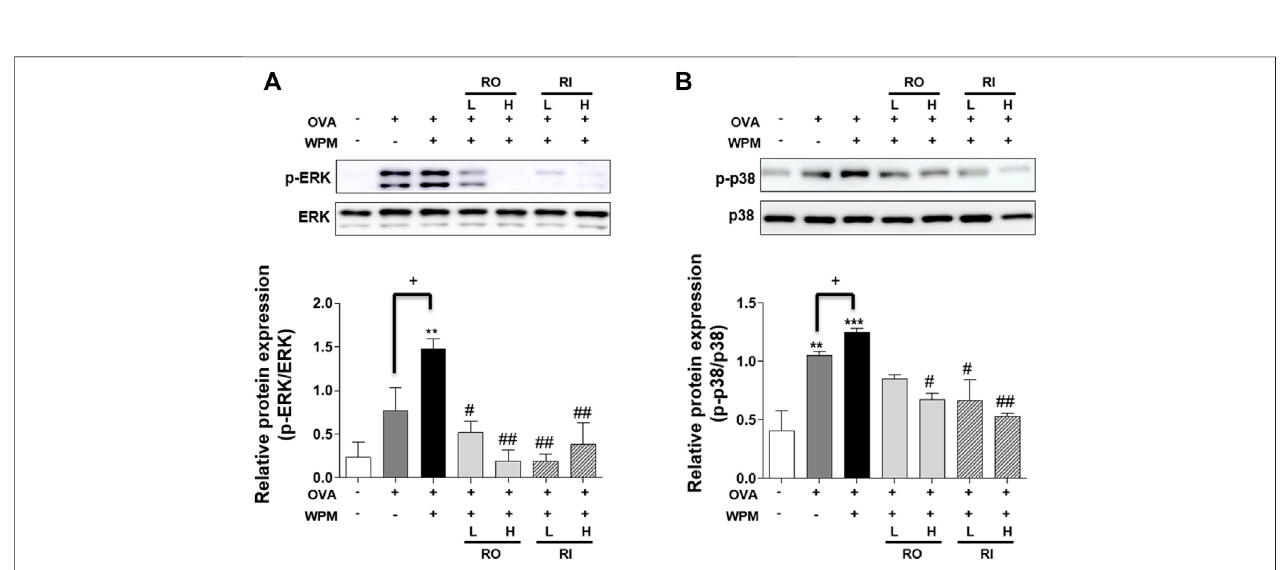
FIGURE 7 | The effects of RL on the MAPK pathway associated protein expression in the lungs of WPM-exacerbated mouse model of asthma. The protein expression level of (A) ERK, (B) p38 were determined using Western blotting. Westernblot results were quanti fi ed using Image J software. All data are presented as the mean±SEM. n =3/group.* p < 0.05and*** p < 0.001comparedwiththecontrolgroup; # p < 0.05, ## p < 0.005and ### p < 0.001comparedwiththeOVA+WPMgroup; + p < 0.05 compared with the OVA group.